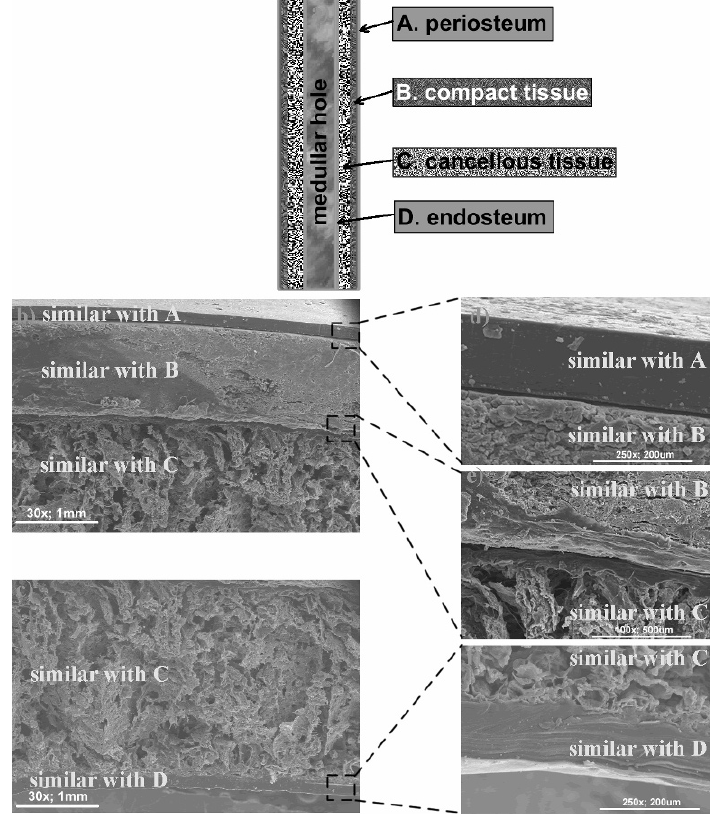
Figure 4. a) Schematic representation of median zone of natural long bones; b, c) SEM images of synthesized median zone of the potential long bone graft, magnification 30× and d-f) SEM images of the three